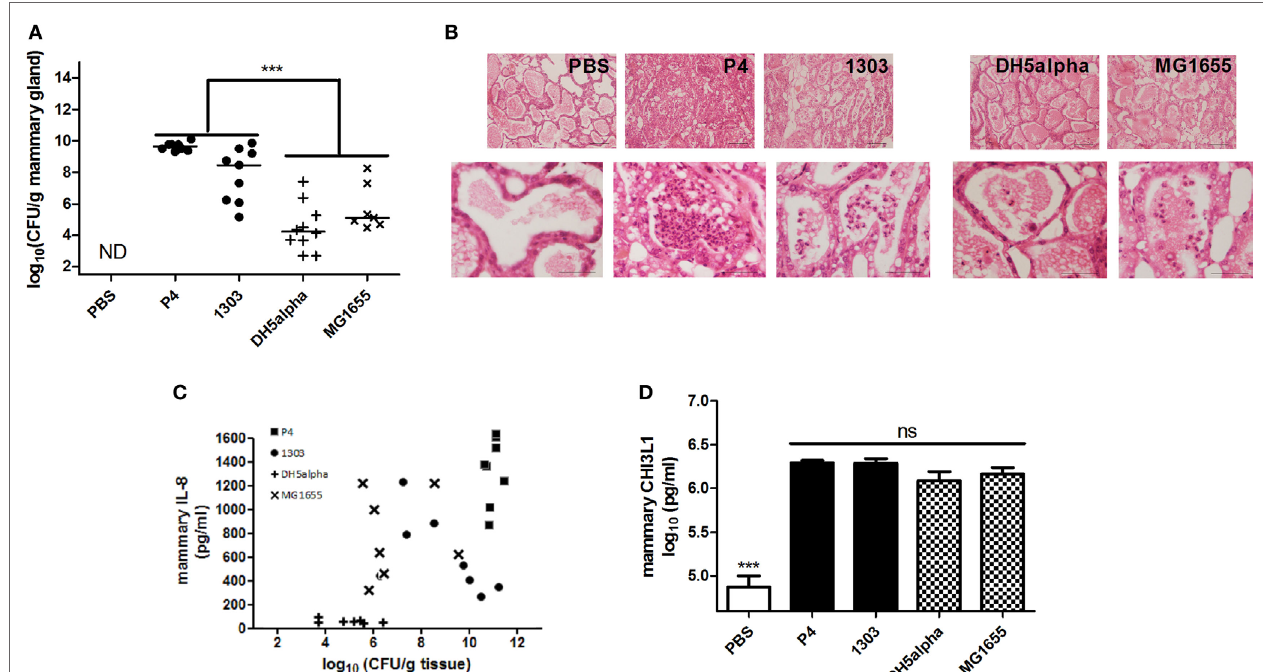
FigUre 2 | Mammary chitinase 3-like 1 (CHI3L1) during mammary pathogenic E. coli (MPEC) and non-MPEC infections in the mouse mastitis model. (a) Bacterial loads in the mammary gland at 24 h p.i. with MPEC strains Escherichia coli P4 and 1303 compared to non-MPEC strains E. coli K12 strains DH5alpha and